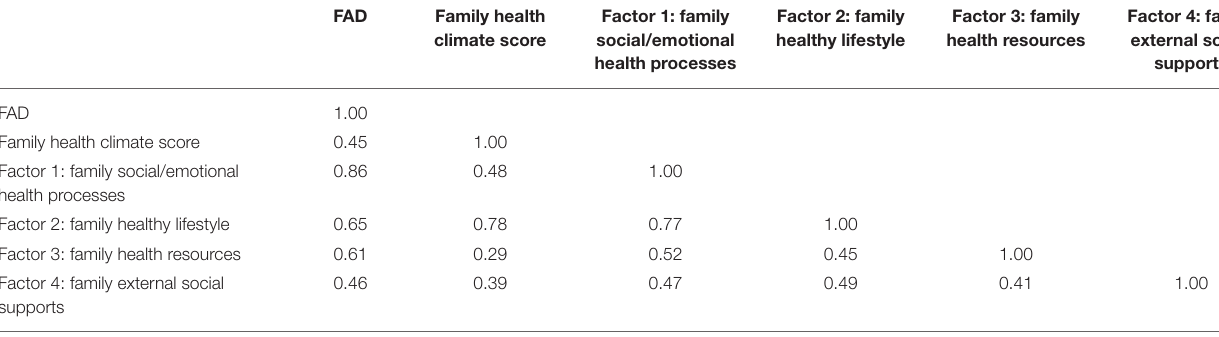
TABLE 5 | Correlation of the FAD and family health climate score with the FHS-LF. Model fit: RMSEA = 0.056; CFI = 0.951.